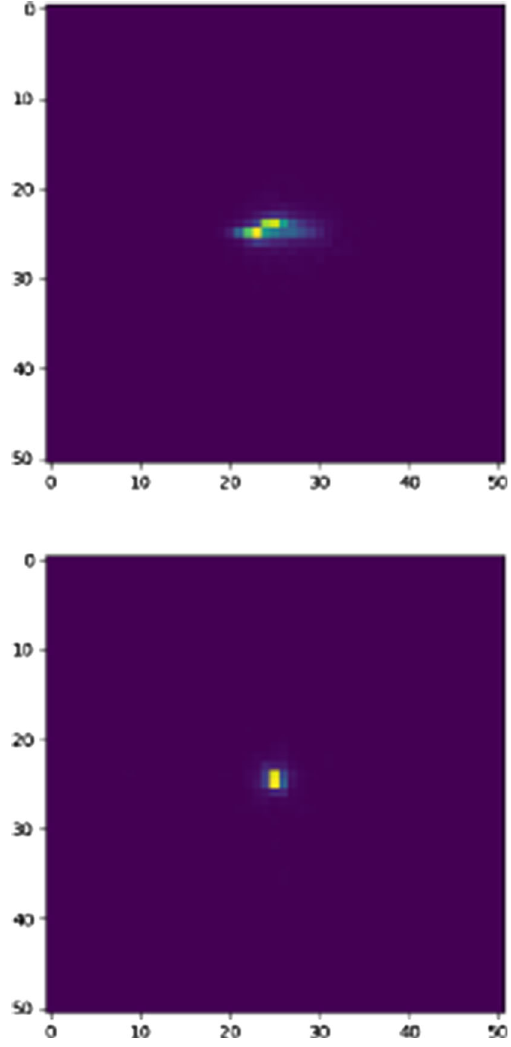
Fig. 24 (Top) (x, y) projection of an event with R9 = 0.42. (Bottom) (x, y) projection of an event with R9 =